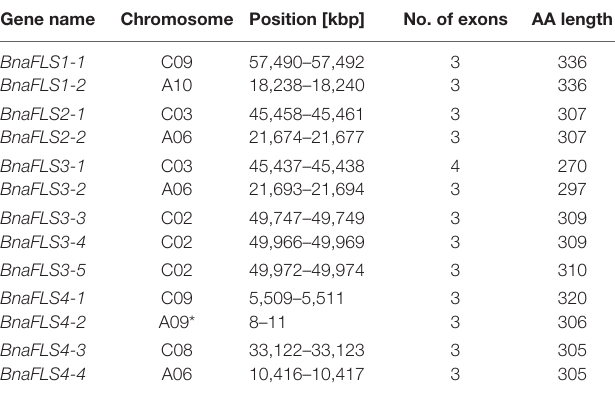
TABLE 1 | Chromosomal location of BnaFLS candidate genes in Express